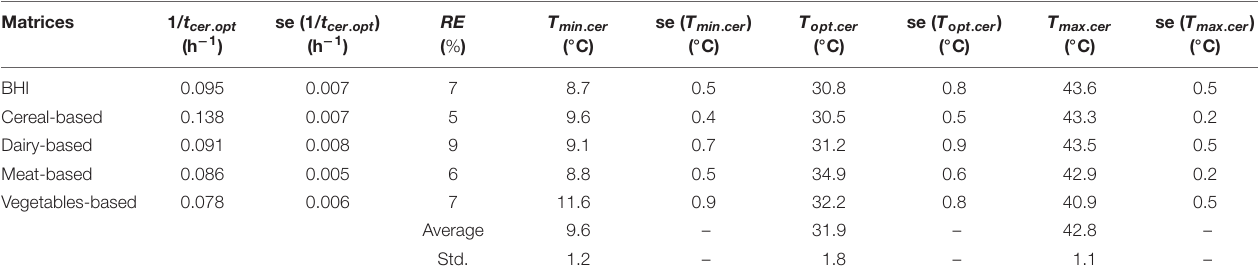
FIGURE 5 | Fitting the square root (Sqrt) of the Cardinal Parameter Models (continuous lines) to square root of observed 1/t cer values (empty symbols) as a function of temperature, in different matrices: BHI (black), cereal- (orange), dairy- (blue), meat- (red), and vegetable-based matrices (green) for strain F4810/72. TABLE 4 | Secondary modeling results for cereulide formation by strain F4810/72 in different